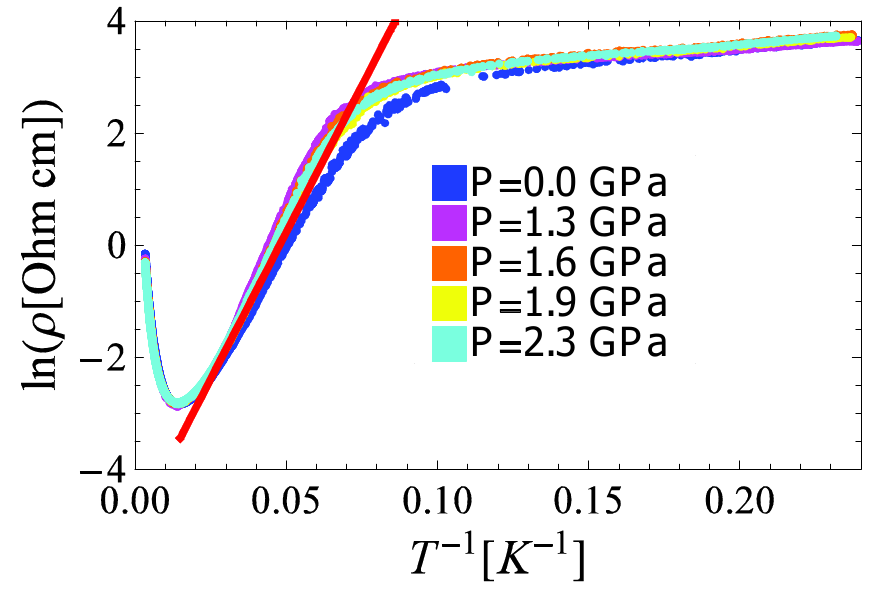
Figure 1. ln( ρ ) versus 1/ T of an anatase single crystal at various pressures. Above 60 K the sample is in the exhaustion regime, with resistivity having a positive slope, whilst below 60 K the conduction is activated. The red line is a fit to the activated behavior, as described in the